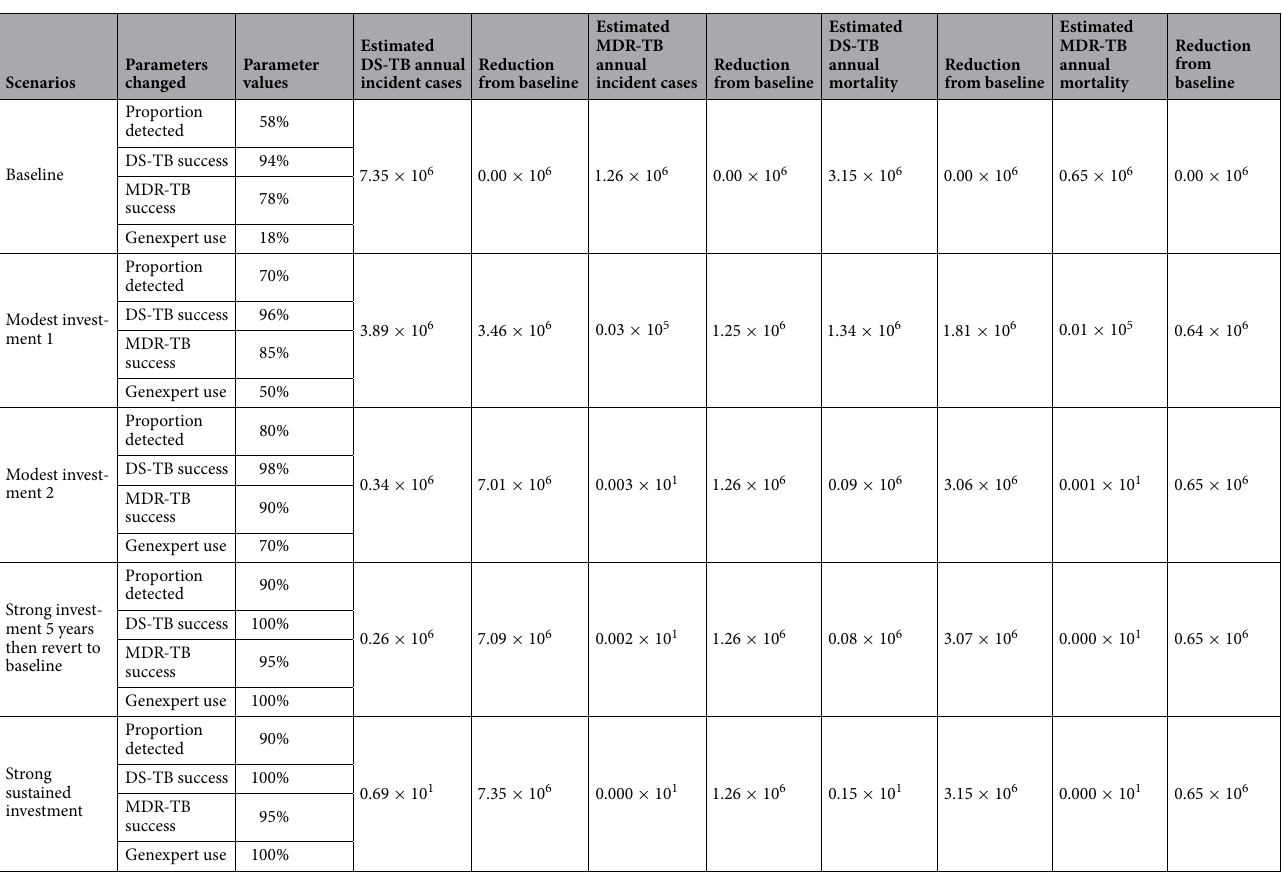
Table 4. Hypothetical combination intervention strategy implemented in our proposed model of DS and MDR-TB control in Bangladesh, for the period